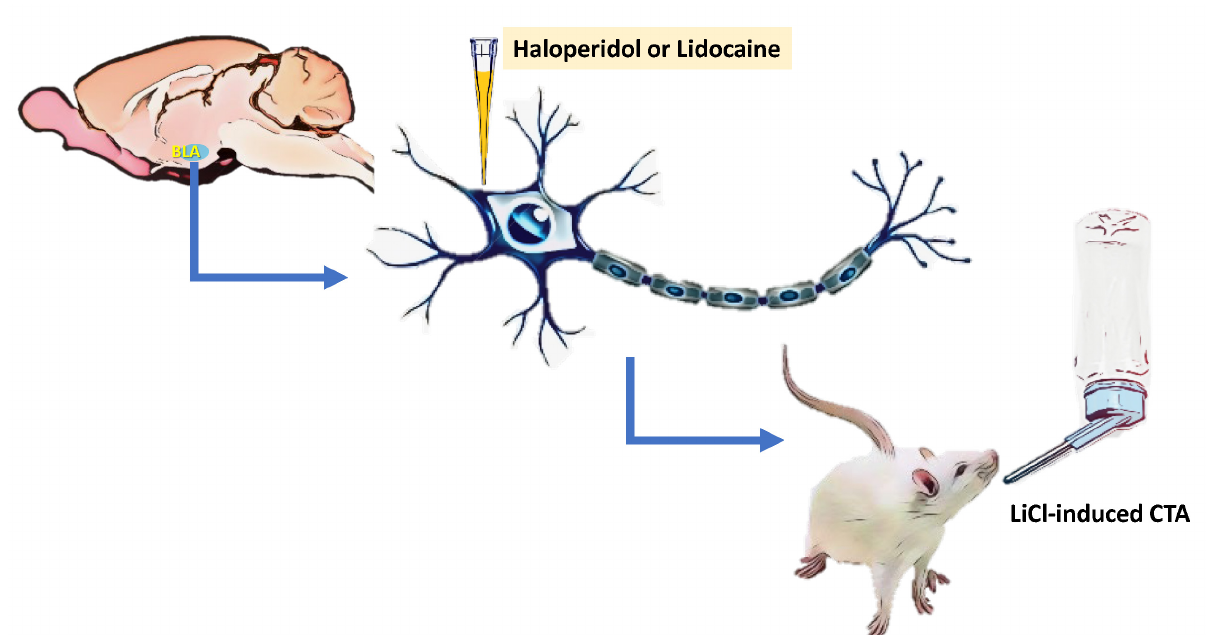
Figure 1. The microinjection of the sodium ion channel blocker, lidocaine, or D2 receptor antagonist, haloperidol into the basolateral amygdala modulates the conditioned suppression of the saccharin solution induced by the emetic drug LiCl.